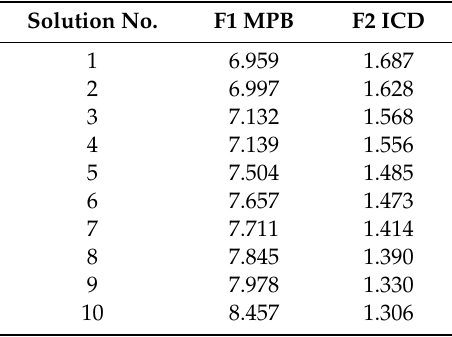
Table 7. Fitness functions for the pair F1–F2. Solution